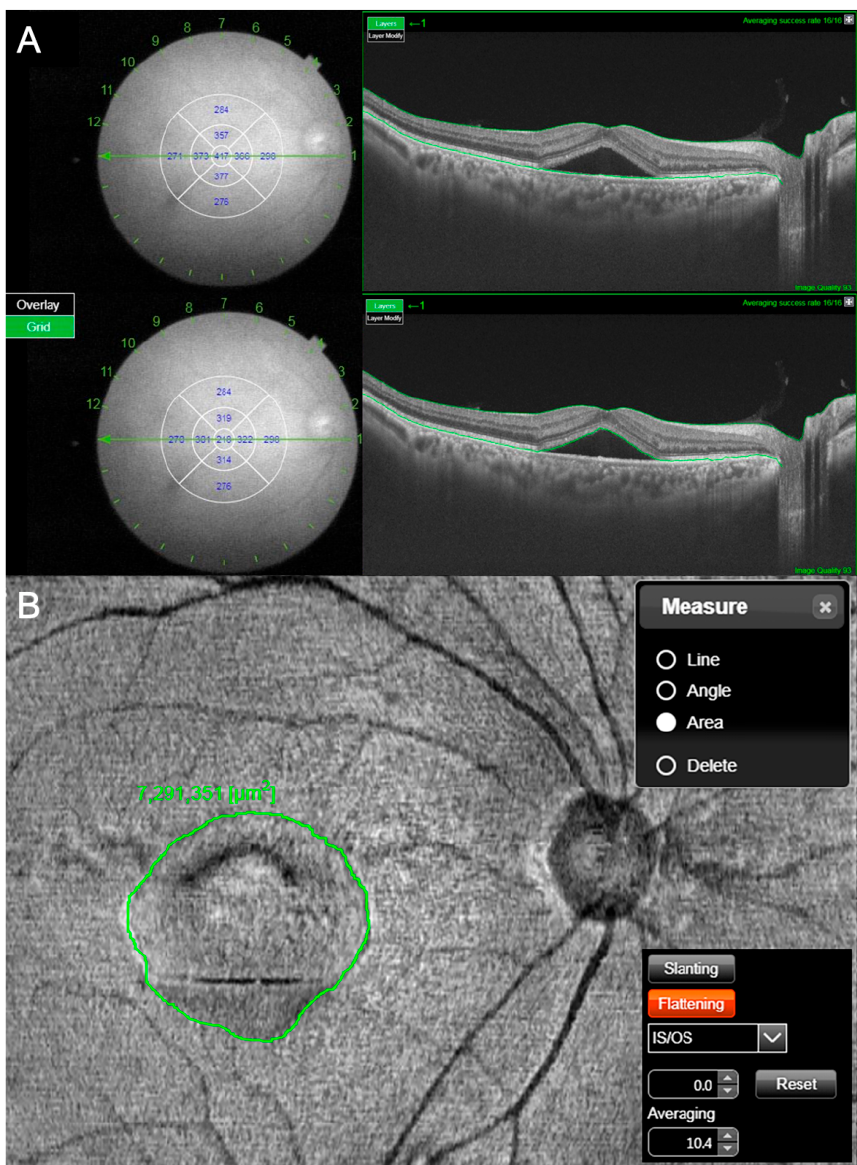
Figure 2. Measurements of subretinal fluid (SRF) height and area were calculated at the initial visit using the 12 radial wide scan and three-dimensional (3D) wide continuous swept-source optical coherence tomography (SS-OCT) mode. The SRF height was defined as the difference between mean total retinal thickness ( A , top image) and mean neurosensory retinal thickness ( A , bottom image) at 1 mm diameter center circle in nine Early Treatment Diabetic Retinopathy Study subfields. The measurements of each layer thickness were performed by semi-automated segmentation with manual corrections using the 12 radial wide scan ( A ). For measurement of SRF area, the 3D OCT scans were reconstructed as en face images. The reference slabs were aligned and flattened to the level of the inner/outer segment. The SRF area was defined as the area inside with contrast change at this level ( B ).